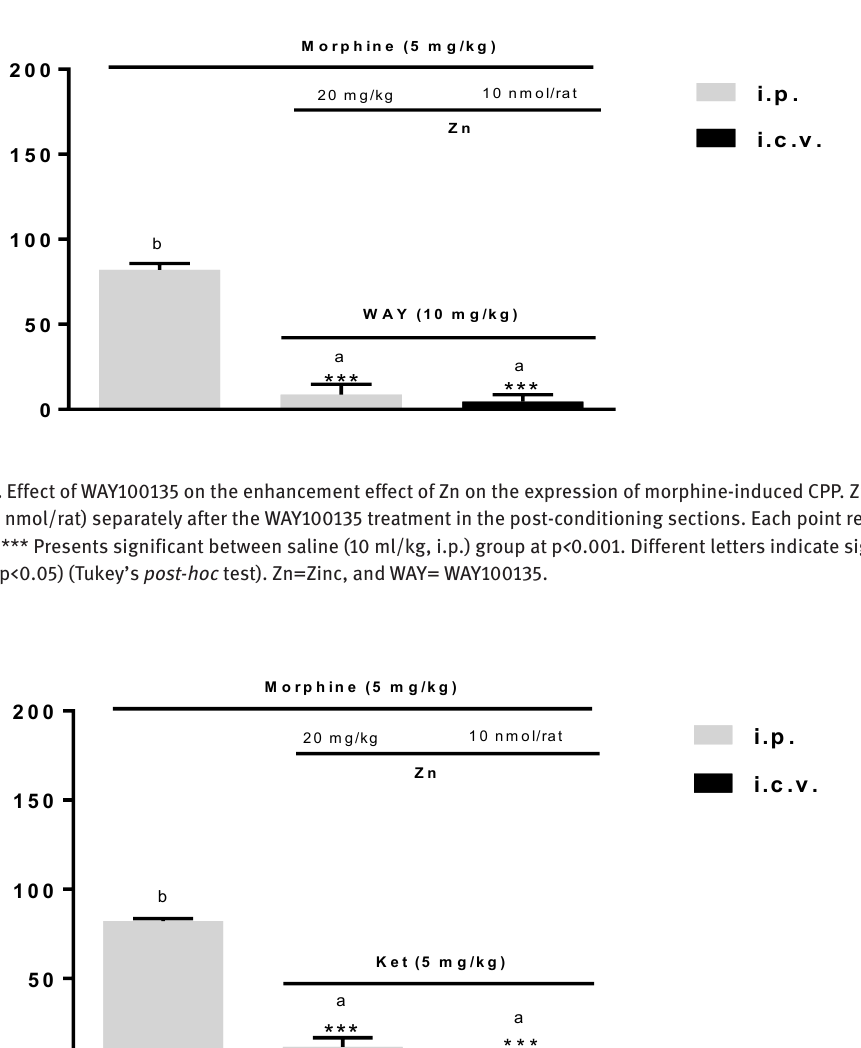
the mean± SEM of six rats.(cid:3) (cid:535)(cid:535)(cid:535)(cid:3) (cid:19)(cid:148)(cid:135)(cid:149)(cid:135)(cid:144)(cid:150)(cid:149)(cid:3) (cid:149)(cid:139)(cid:137)(cid:144)(cid:139)(cid:136)(cid:139)(cid:133)(cid:131)(cid:144)(cid:150)(cid:3) (cid:132)(cid:135)(cid:150)(cid:153)(cid:135)(cid:135)(cid:144)(cid:3) (cid:149)(cid:131)(cid:142)(cid:139)(cid:144)(cid:135)(cid:3) (cid:523)(cid:883)(cid:882)(cid:143)(cid:142)(cid:512)(cid:141)(cid:137)(cid:481)(cid:3) (cid:12)(cid:19)(cid:524)(cid:3) (cid:137)(cid:148)(cid:145)(cid:151)(cid:146)(cid:3) (cid:131)(cid:150)(cid:3) (cid:146)